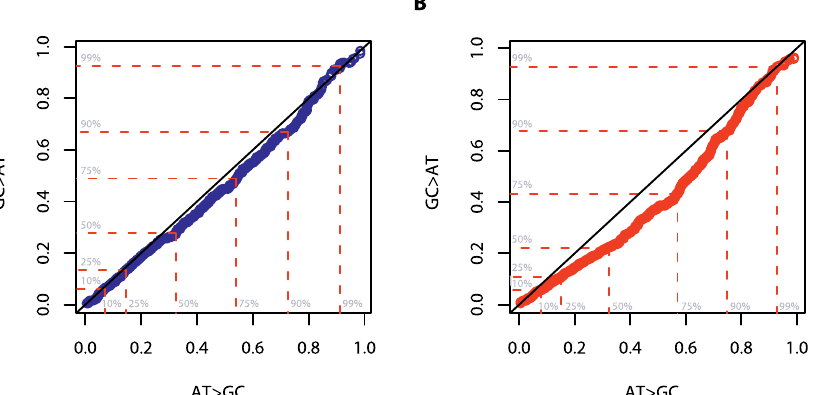
Figure 5. Quantile-Quantile Plots Showing the Difference in Allele Frequency Spectrum for AT ! GC Mutations and GC ! AT Mutations in Regions of Low and High Recombination If the two types of mutation were to have the same allele frequency distribution, we would expect to see a straight line. In both cases, AT ! GC mutations are typically at higher frequencies than GC ! AT mutations; however, the effect is more pronounced in regions of high recombination [(A), low recombination; (B), high recombination]. A quantification of the difference can be found in the text and supporting material. DOI: